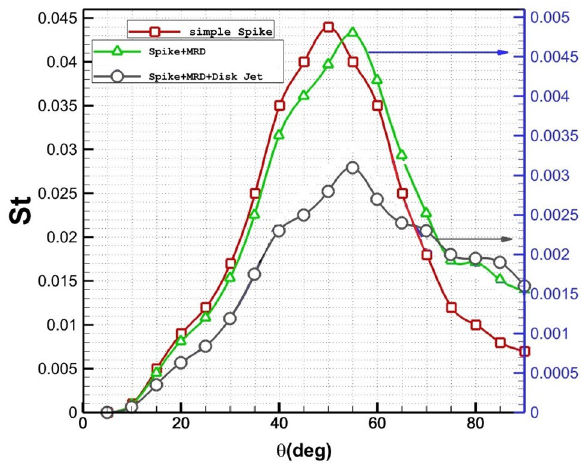
Figure 8. Heat transfer on the main body and disk in different conditions.